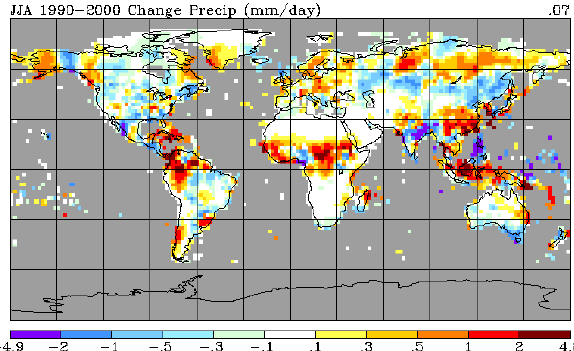
Fig. 12. Trend in summer (June to August) precipitation (in mm/d) from 1990 to 2000 using observations from the Indian Meteorolog- ical Department (IMD) data Rajeevan et al.